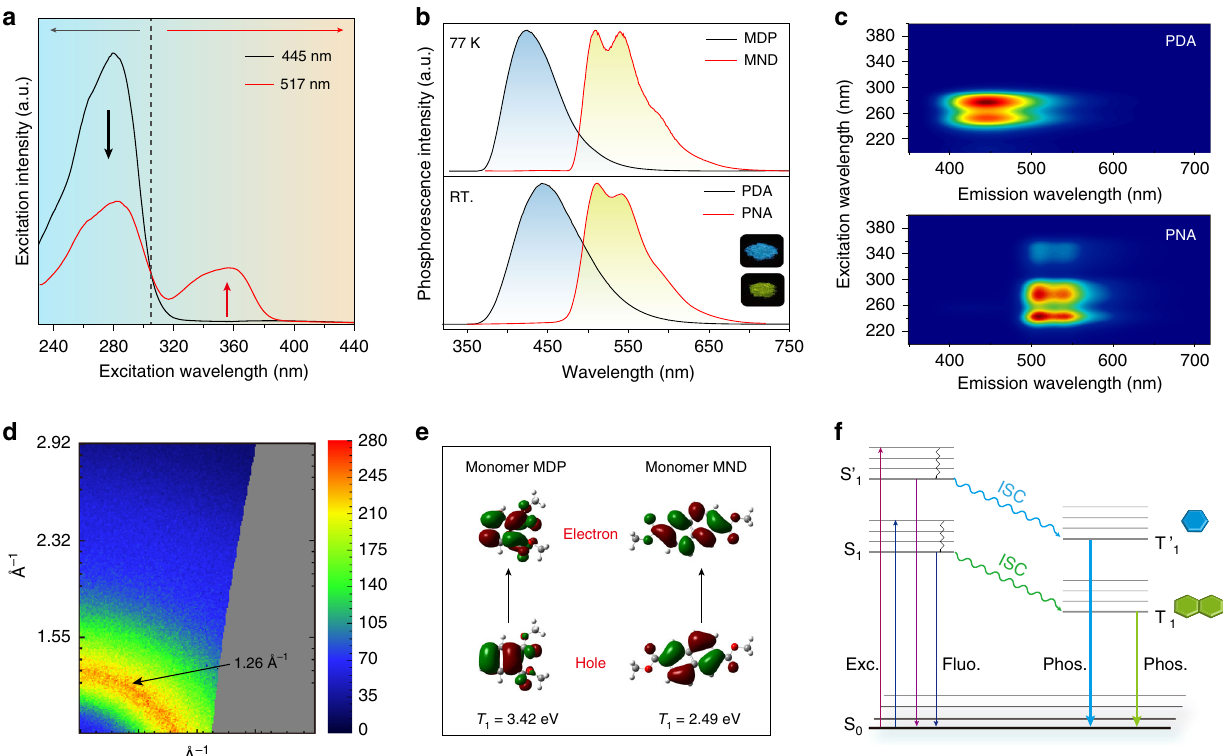
Fig. 3 Mechanism of color-tunable UOP in multicomponent copolymer at room temperature. a Phosphorescence excitation spectra in polymer PDNA at 445 and 517 nm. b Normalized phosphorescence spectra of monomer MDP and MND in 2-methyltetrahydrofuran (1 × 10 − 5 M) at 77 K (top), as well as polymer PDA and PNA at room temperature (RT) (bottom) excited at 280 and 360 nm. c Polymer fi lm excitation – phosphorescence mapping of PDA (top) and PNA (bottom) at room temperature. d WAXS pattern of polymer fi lm PDNA. e Natural transition orbitals for the lowest triplet transitions of MDP and MND in gaseous state. f Proposed mechanism of the color-tunable UOP in multicomponent copolymer. Fluo. fl uorescence, Phos. molecular phosphorescence, Exc.